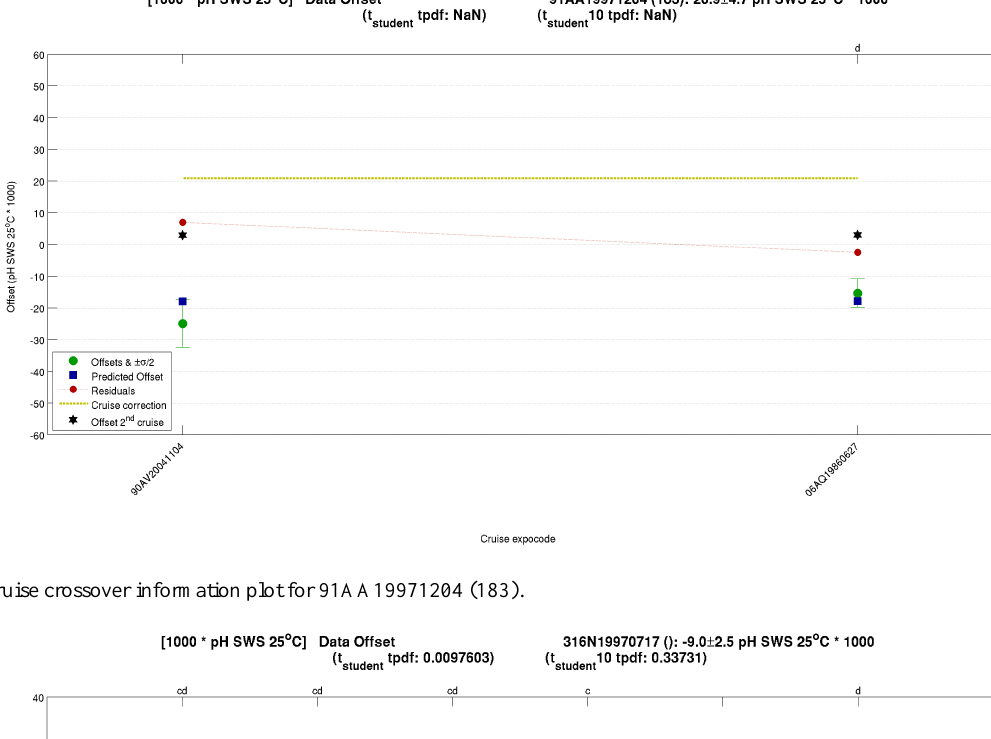
Figure 21. Cruise crossover information plot for 91AA19971204 (183).